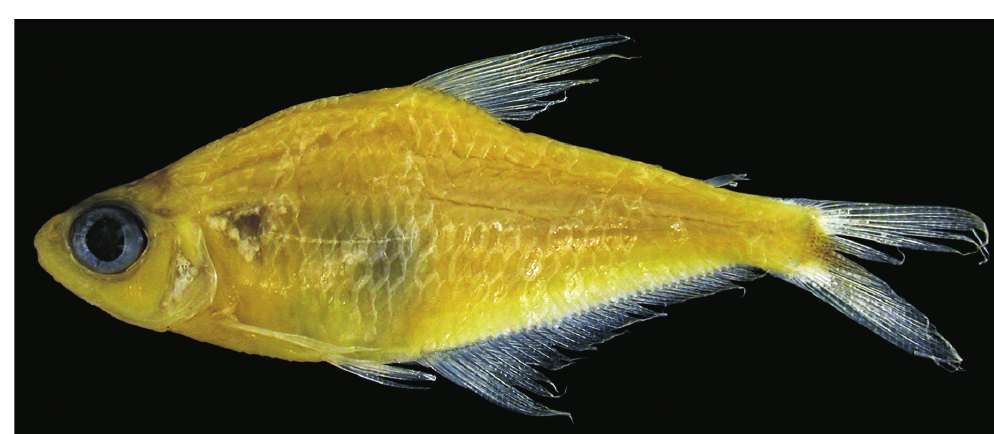
Figura 5. Phenacogaster napoatilis sp. nov. , MCZ 51485, holótipo, 32,6 mm CP, Rio Napo e afluentes,